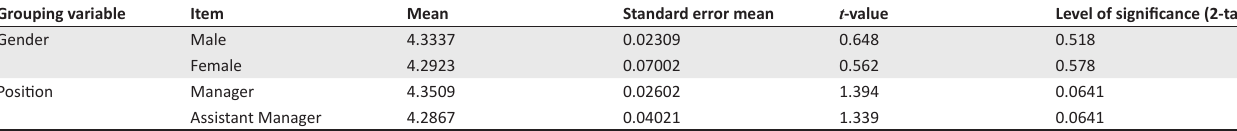
TABLE 3: t -Test – organisational change based on gender and position. Grouping variable